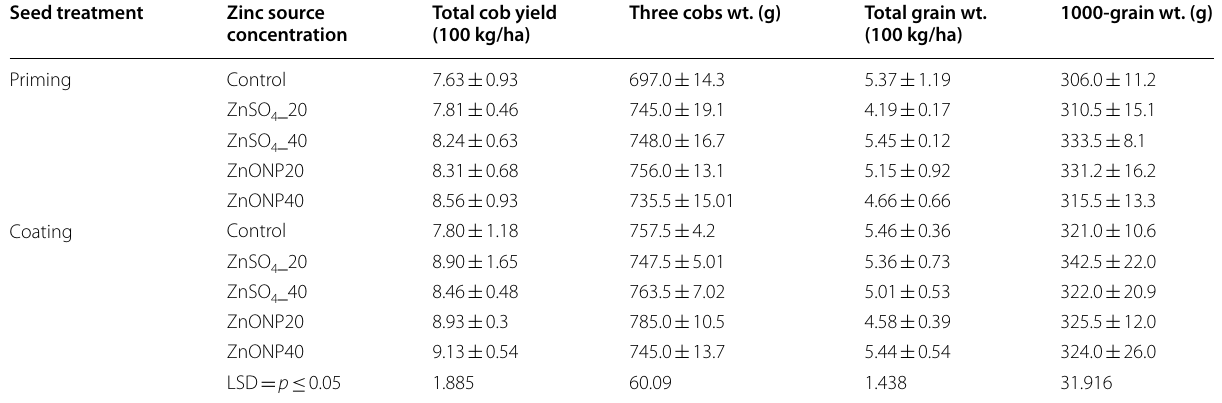
Values represent the average mean